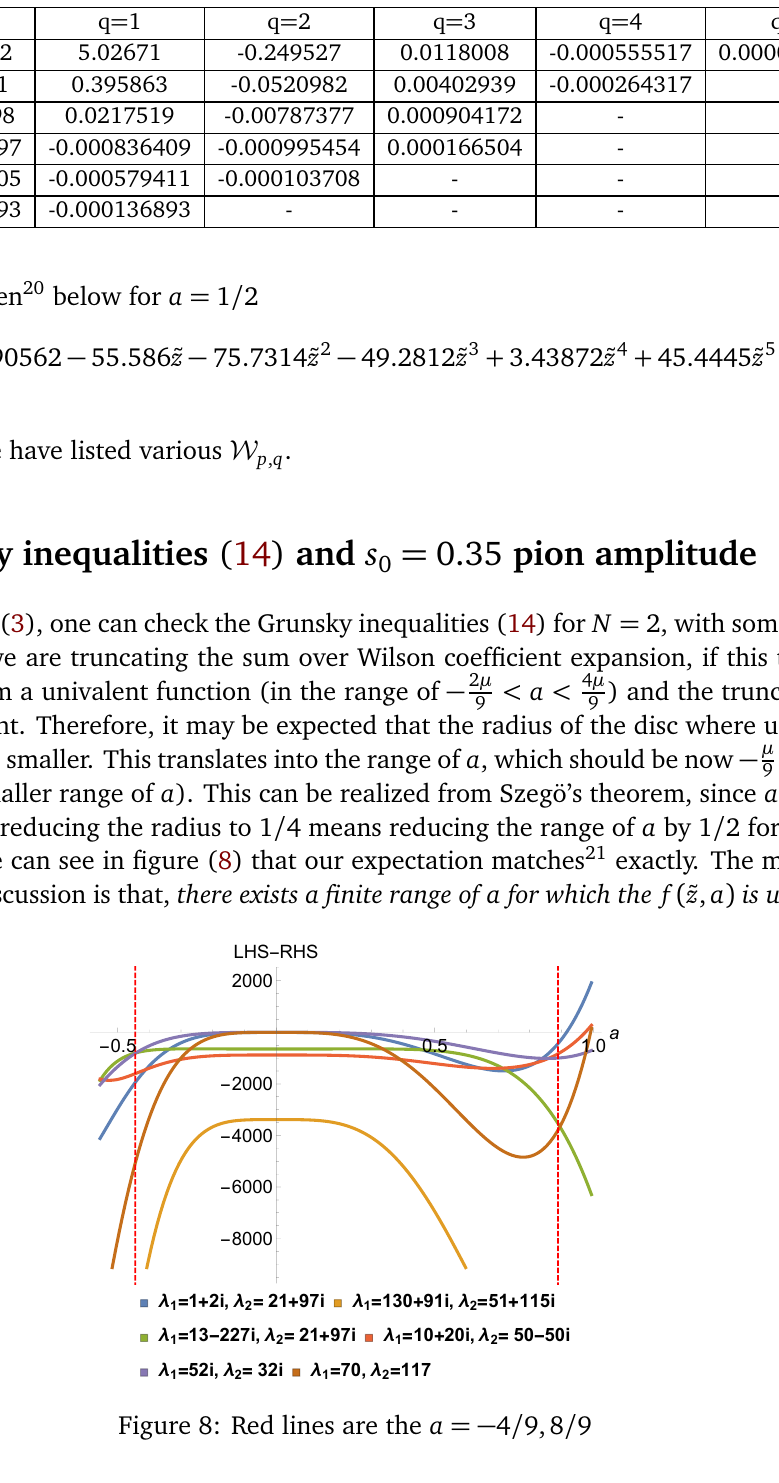
Table 3: W for pion scattering from S-matrix bootstrap with s p , q